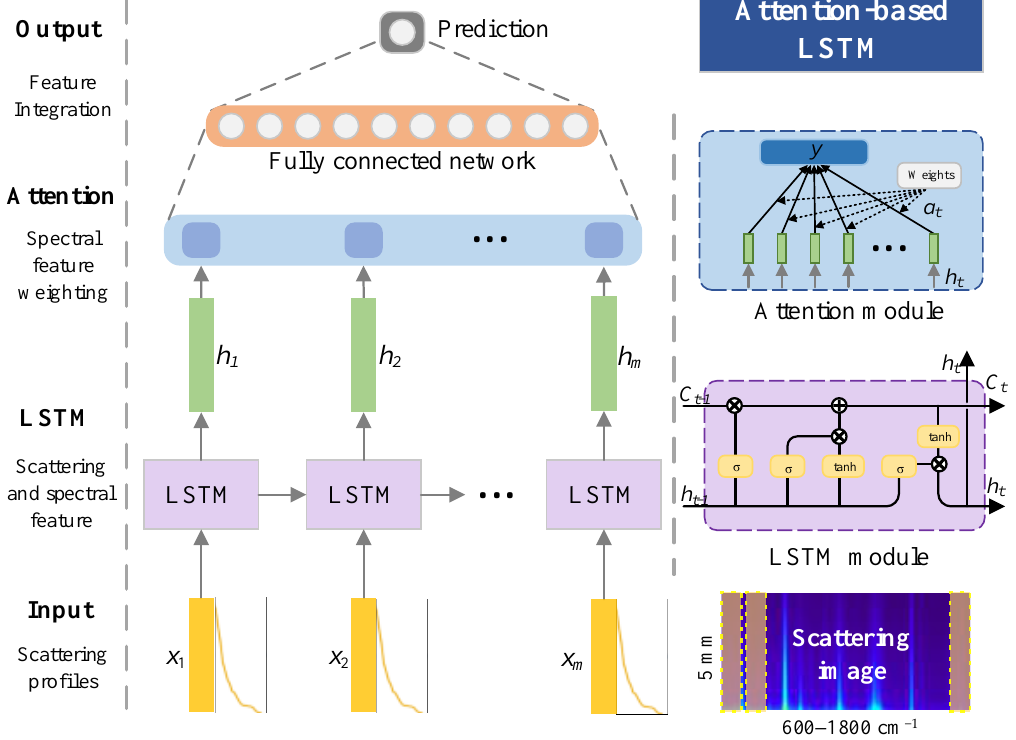
Figure 3. Schematic diagram of the deep network structure of attention-based LSTM. ( m = 200 is the number of input characteristic bands, x is the scattering profiles of different bands, and h is the scattering feature extracted by LSTM modules.)